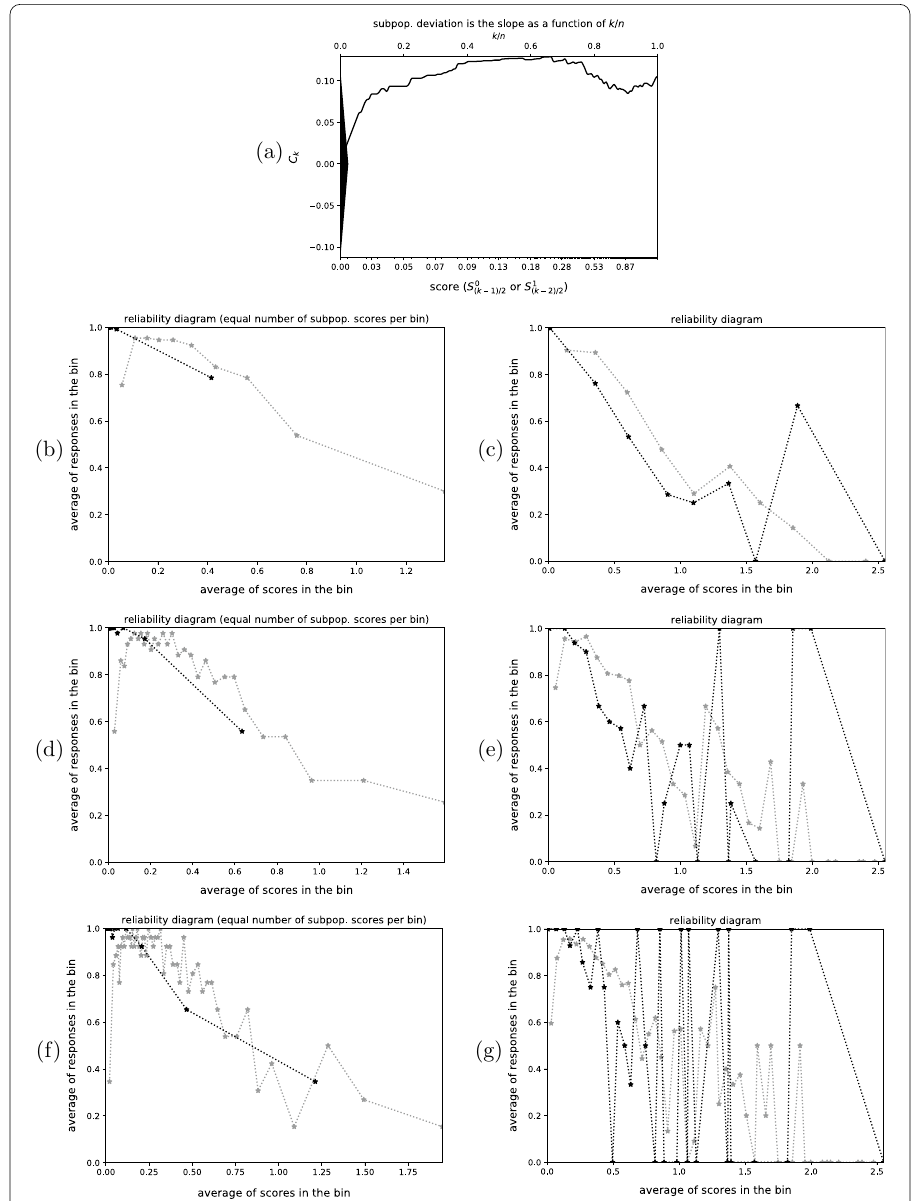
Fig. 9 Monarch (or milkweed) butterfly (Danaus plexippus) vs. Wild boar (Sus scrofa); n = 315; Kuiper’s statistic is 0.1292 /σ = 2.294 , Kolmogorov’s and Smirnov’s is 0.1292 /σ = 2.294 ; the reliability diagrams with 30 bins or less ( b , c , d , and e ) underestimate (or fail to resolve) the extreme deviation at the lowest scores, whereas the diagrams with 50 bins ( f and g ) are far too noisy for the other scores. The graph of cumulative differences ( a ) resolves all these behaviors clearly. The metrics of Kuiper and of Kolmogorov and Smirnov both report somewhat statistically significant deviations between the subpopulations, though much less extreme than in Figs. 7 and